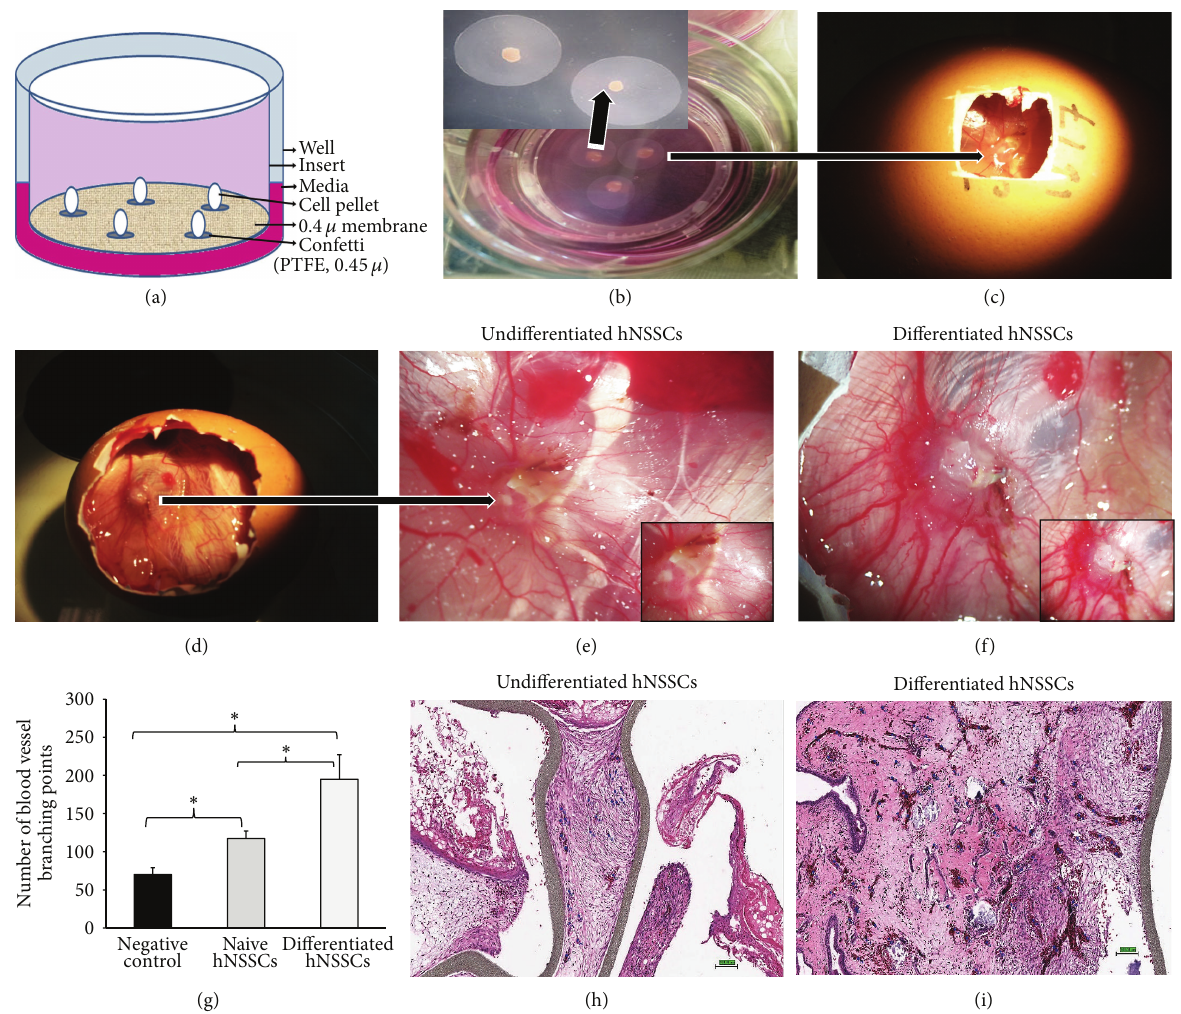
Figure 3: hNSSCs contribute to neovasculature using ex vivo CAM model. (a) Schematic illustration of the organotypic culture system (liquid-air interface). hNSSCs pellets were placed on the top of a confetti that is in contact with the membrane on the insert. The media diffuse across the insert membrane and confetti to reach the pellet. Microscopic aspect of chick chorioallantoic membrane (CAM) and organotypic cultured hNSSCs with confetti grafted to it. (b) hNSSCs pellet placed on top of a piece of confetti that is in contact with the membrane on the insert. (c) Window (2cm 2 ) made in the egg shell of a 10-day-old chick embryo with organotypic culture transplanted. (d) After 10 days, implantation shell was opened and blood vessel points were observed; (e and f) note the wheel-spoke pattern of CAM blood vessels around the graft (undifferentiated and differentiated). Stimulation of angiogenesis in CAM by undifferentiated or differentiated hNSSCs. The expansion of new blood vessels was determined by counting branch points after 10 days of cell transplantation. Sprouting and branching vessels are prominent in the CAM transplanted by differentiated hNSSCs compared to the undifferentiated hNSSCs transplantation. (g) Quantification of new blood vessels formed by naive (undifferentiated) and differentiated hNSSCs compared to negative control (confetti without cell transplantation) ( 𝑛 = 5 ). ∗ 𝑃 < 0.05 . (h, i) Paraffin sections of both undifferentiated and differentiated hNSSCs transplanted CAM were stained by haematoxylin and eosin stain to show the vascular density in CAM; blood vessels were counted again (blue colour points indicate vasculature) with Aperio’s ImageScope software (Aperio Technologies, Vista, CA, USA) (Bar = 100 𝜇